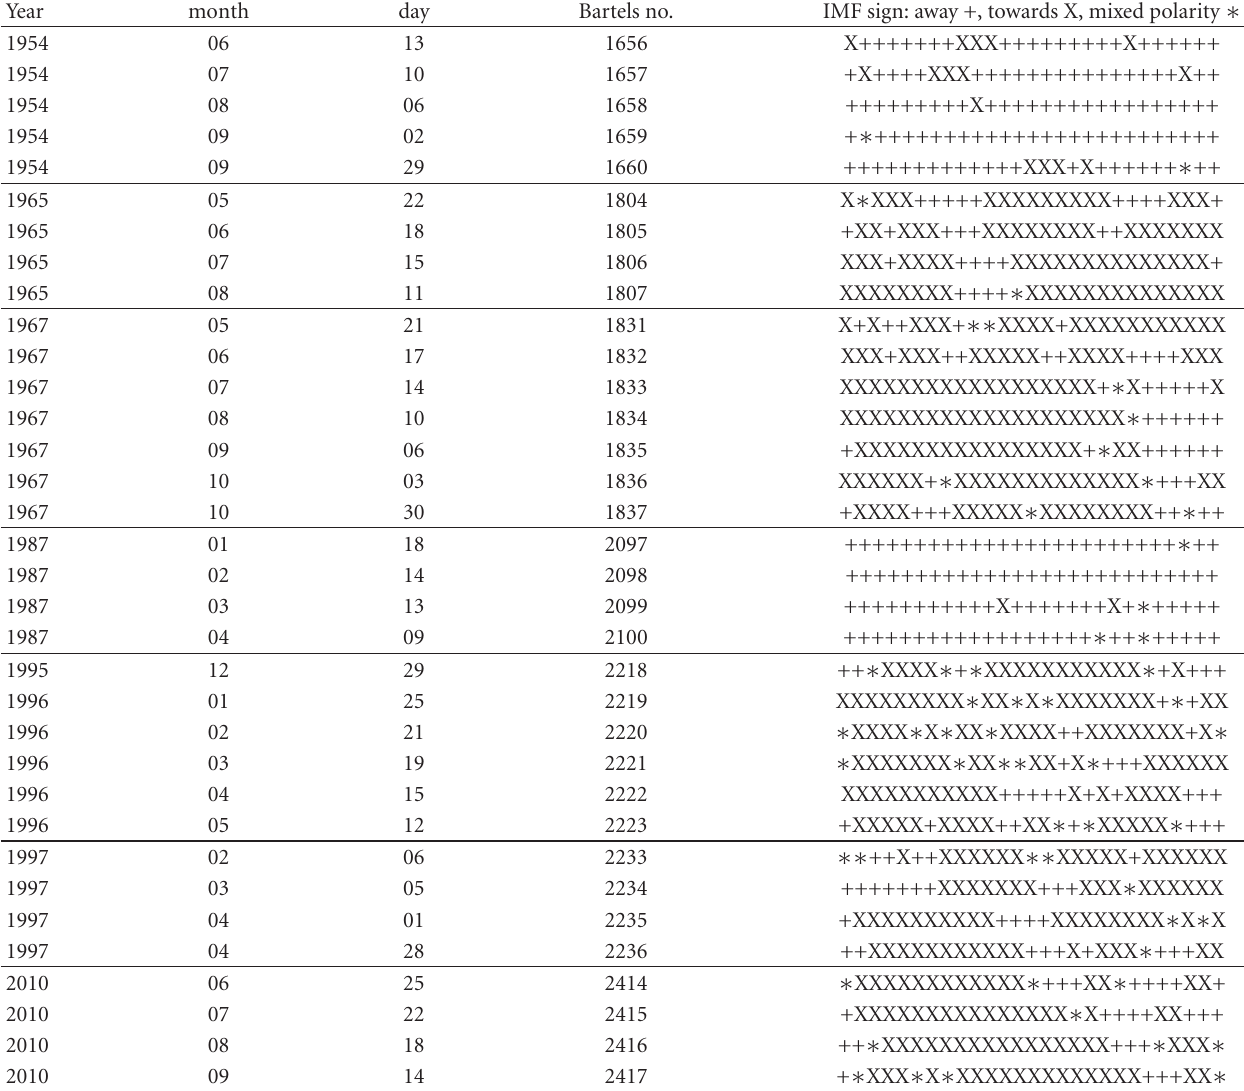
Table 1: Wilcox [34] suggested that the interplanetary field (IMF) showed a monopole-like behavior, when the IMF, or its proxy, showed time intervals when it was predominantly pointed towards or away from the Sun for a good fraction of a solar rotation. Svalgaard [41] shows the following time periods with unipolar